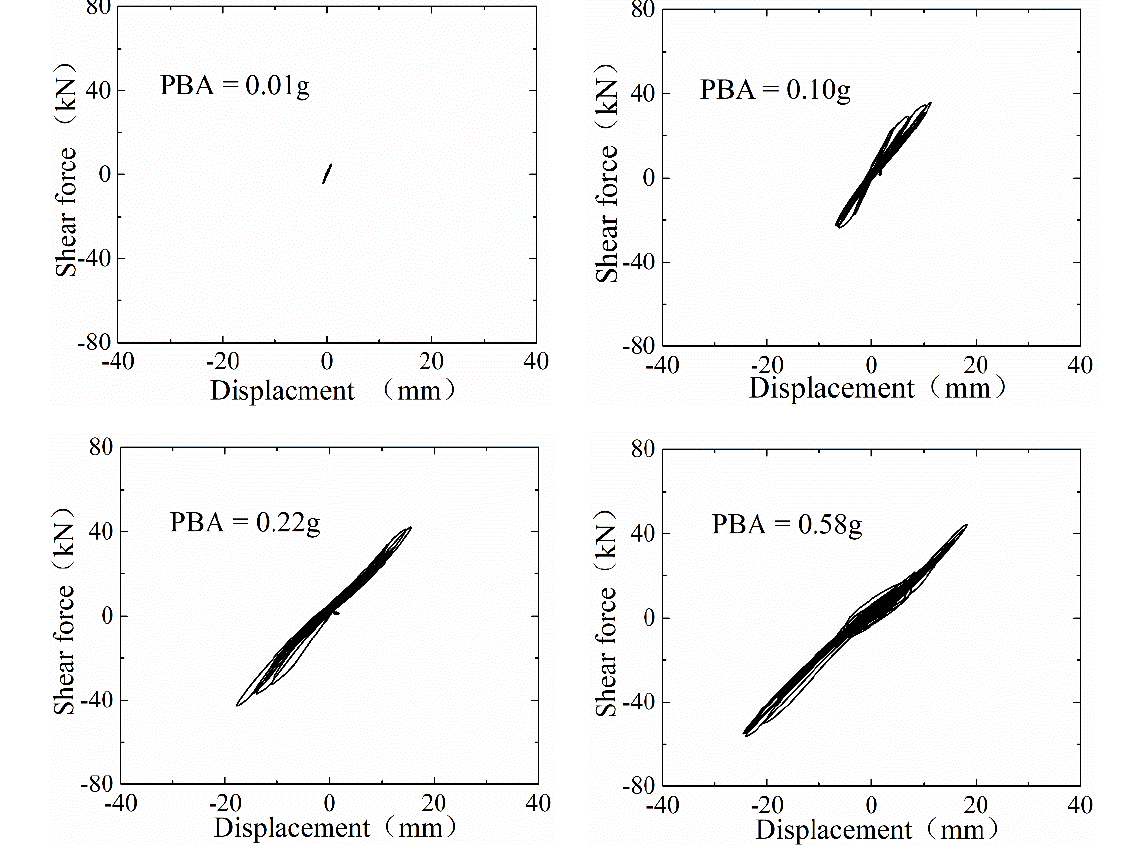
Figure 10. Curve of the force-displacement hysteretic response.